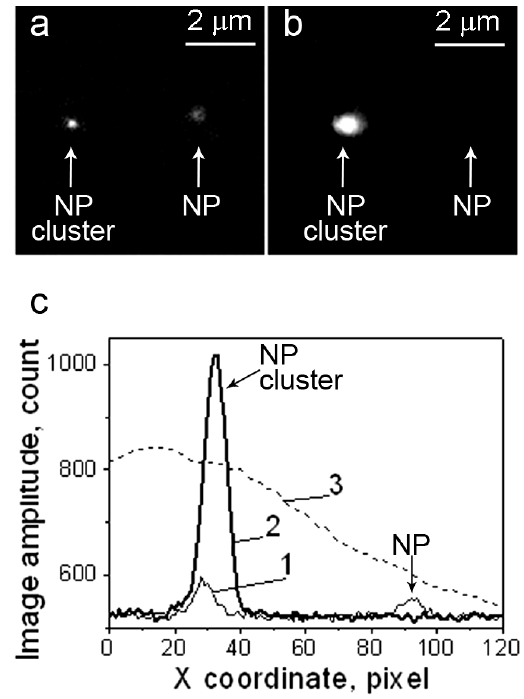
Figure 7. ( a ) optical scattering images of a 90 nm gold NP and a cluster of 90 nm NPs; ( b ) the same objects showing attenuation and amplification of scattering upon their exposure to a pump pulse (532 nm, 0.5 ns) that induced a bubble around the NP cluster but not around the NP; ( c ) the spatial profile of the pump laser (3) shows the difference in the fluence applied and the profiles of the scattering amplitudes: 1—case (a), 2—case (b)